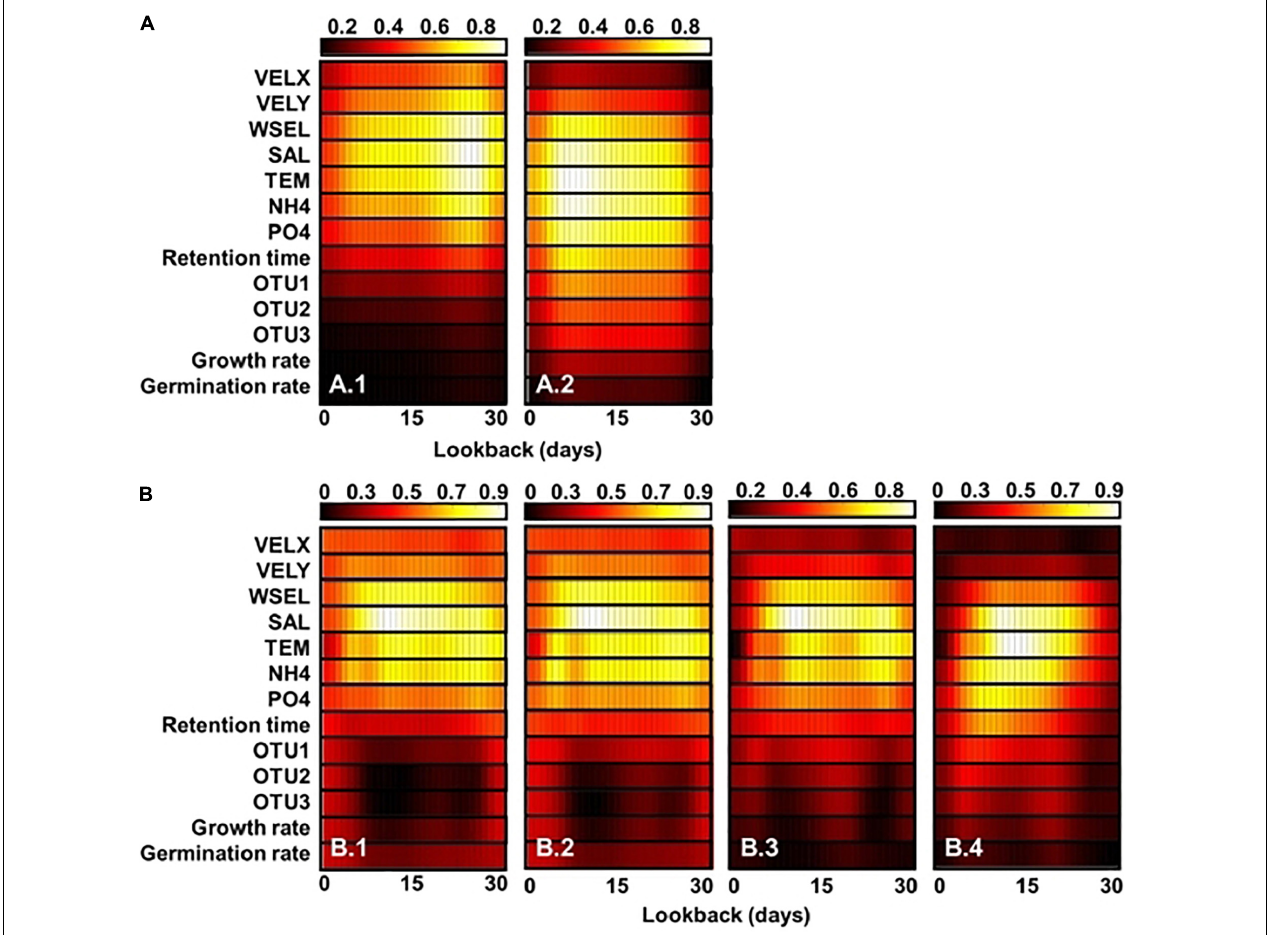
FIGURE 6 | Feature heat maps of classification (A) and regression (B) CNN models obtained using Grad-CAM for the (A.1) bloom and (A.2) no-bloom conditions as well as cases wherein the A. catenella density lies in the (B.1) 5–25, (B.2) 25–50, (B.3) 50–75, and (B.4) 75–90 percentile ranges. The x and y axes represent the lookback and variables values, respectively. The color indicates the degree importance from the lowest (black) to the highest (white). The larger the variable value in a given cell, the greater is its importance. VELX, VELY, WSEL, SAL, TEM, OTU1, OUT2, and OUT3 denote the longitudinal velocity, latitudinal velocity, water-surface elevation, salinity, water temperature, microparticle-associated bacteria, nanoparticle-associated (NP) bacteria, and free-living (FL) bacteria,